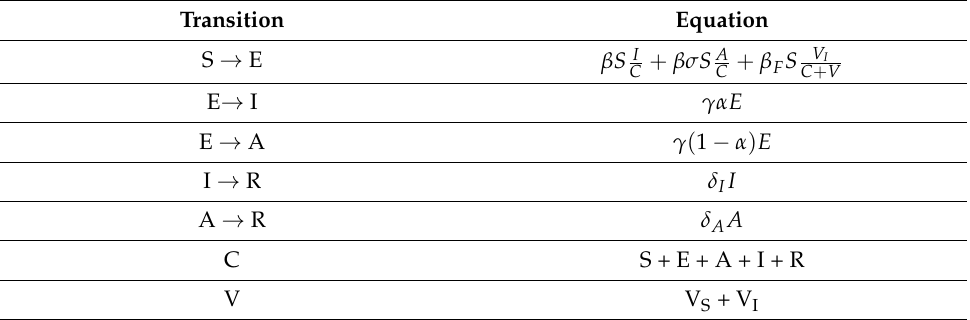
Table 1. Transitions and equations for a model of COVID-19 transmission due to in-person sporting events.